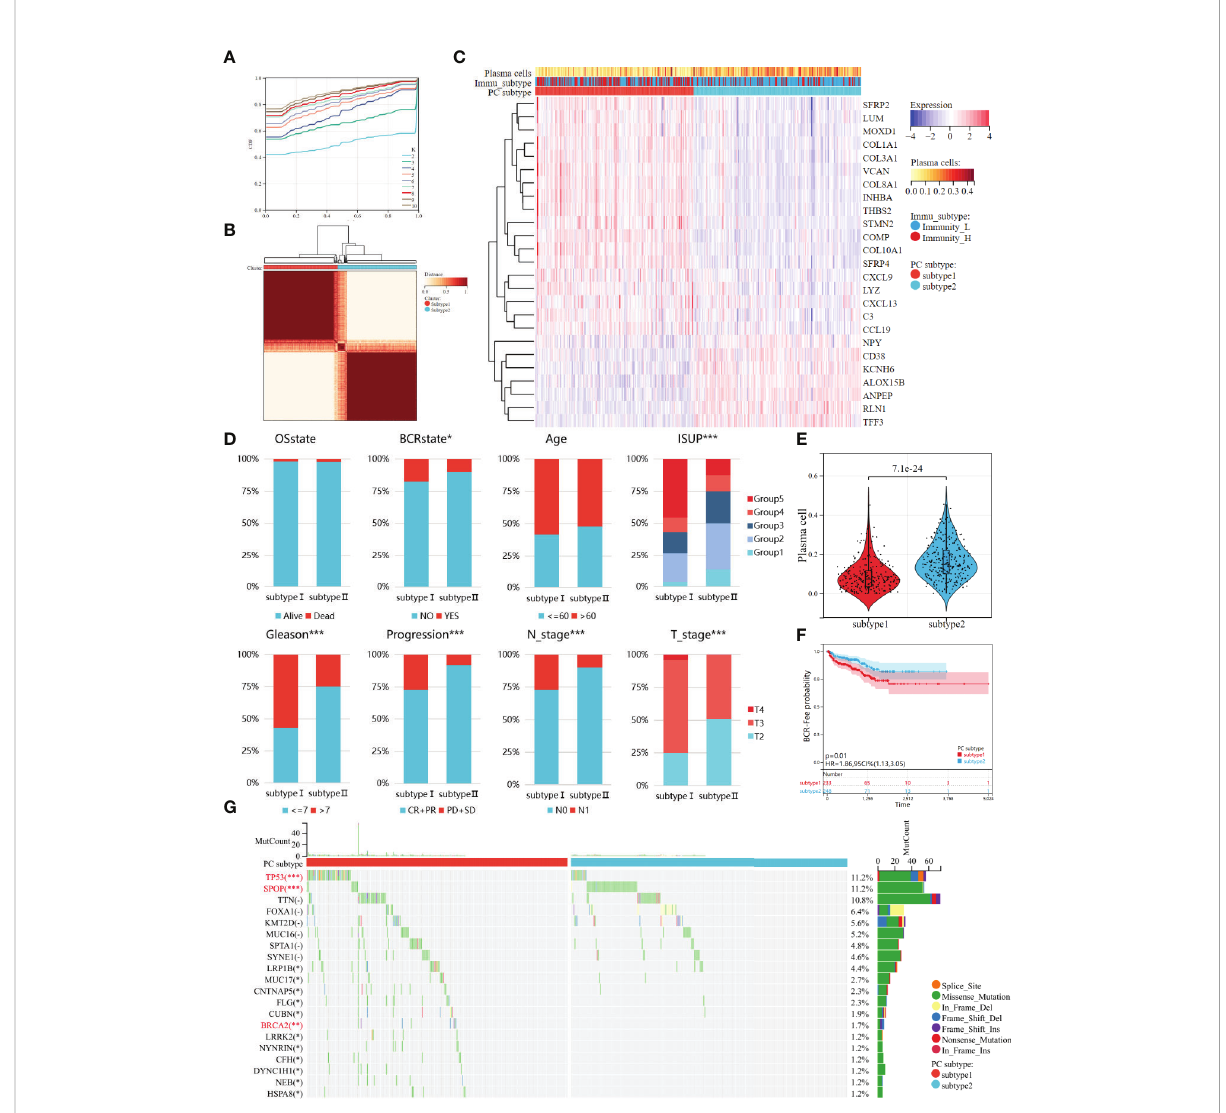
FIGURE 4 Two molecules subtypes of plasma cell with different clinical characteristics, biochemical recurrence probability, and mutant landscape. (A) The CDF curves of the consensus score from k = 2 to 10. (B) The Consensus clustering matrix when the best K = 2. (C) The heatmap of the expression patterns of 25 DEGs, with red indicating high expressions and blue indicating low expressions. (D) Comparison of clinical features between two plasma cell subtypes. (E) Kaplan – Meir survival analysis exhibited signi fi cantly worse BCR-free survival probability in plasma cell subtype 1. (F) Plasma cell fraction was higher in plasma cell subtype 1. (G) Waterfall plots showed the top 20 mutated between plasma cell subtype. *P < 0.05, **P < 0.01, ***P <